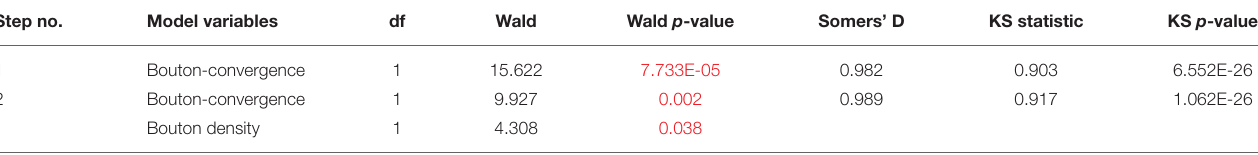
TABLE 10 | Summary of building the stepwise logistic regression model. Step no.